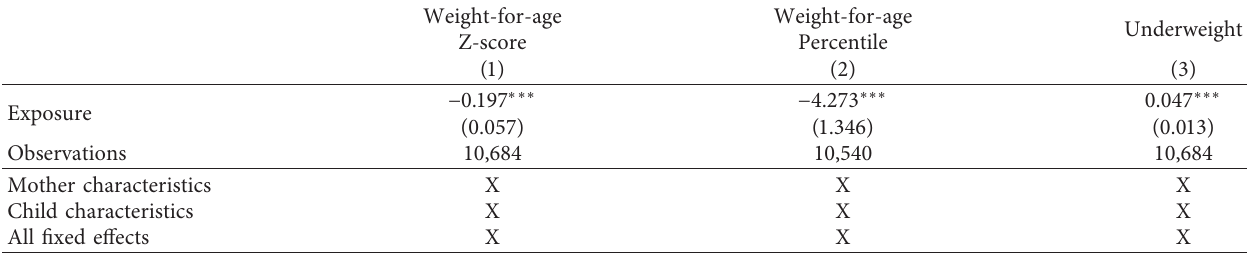
Table 3: Exposure to armed conflict on child weight-for-age: main results.